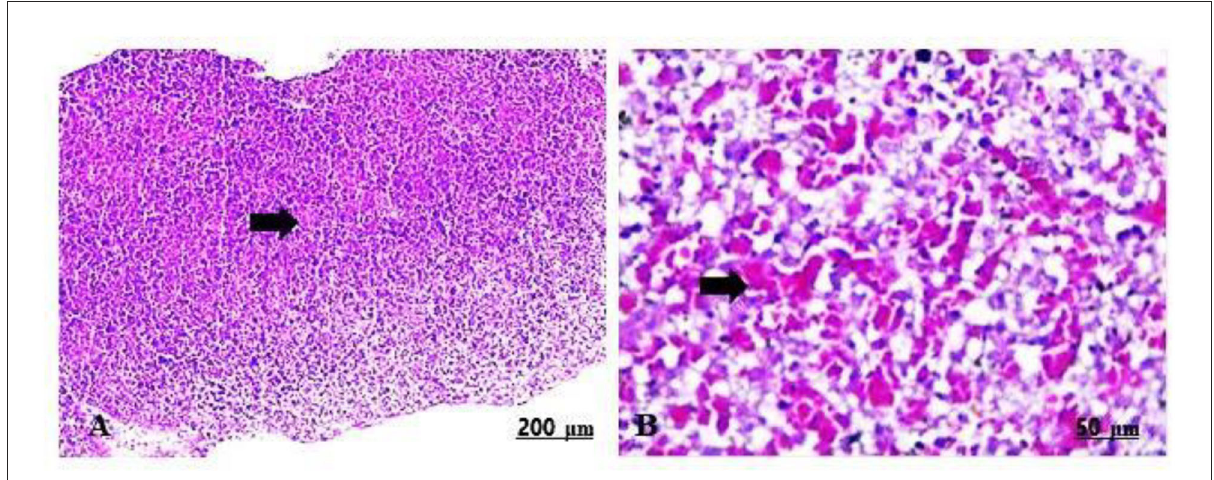
FIGURE3 (A,B) Light photomicrograph of sections from the fetal liver of control stained with H&E: control showing intense infiltration of hematopoietic cells, mainly RBCs and lymphocytes in the blood sinusoids (A,B) .